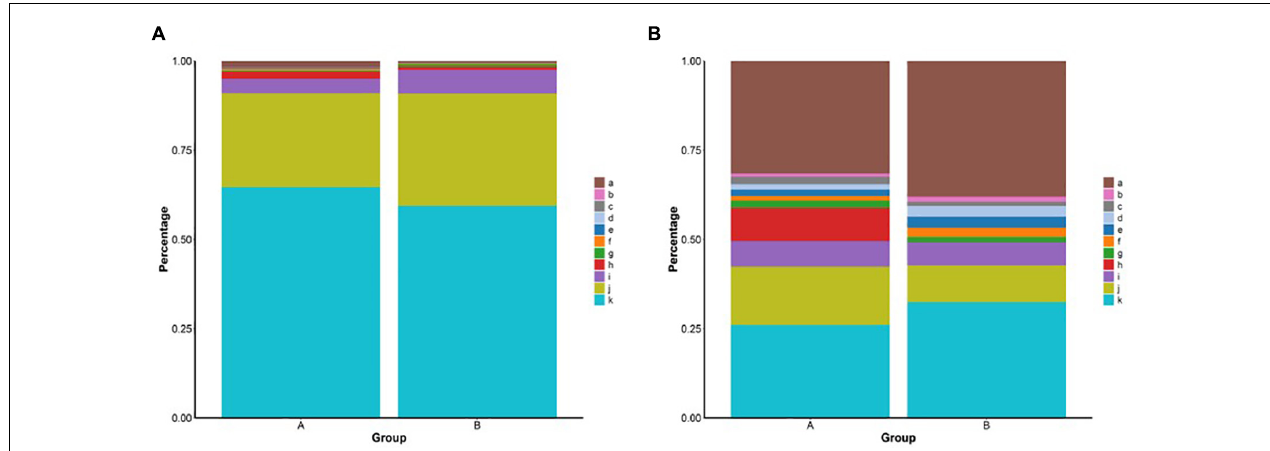
FIGURE 1 | (A) Relative abundance of bacteria phyla from the group A and group B. a: Others, b: Deinococcus-Thermus , c: Patescibacteria , d: Epsilonbacteraeota , e: Spirochaetes , f: Actinobacteria , g: Cyanobacteria , h: Firmicutes , i: Bacteroidetes , j: Tenericutes , and k: Proteobacteria. (B) Relative abundance of bacteria genus from different groups. a: Others, b: Formosa , c: Caulobacter , d: Ruegeria , e: Halocynthiibacter , f: Tamlana , g: Pseudoalteromonas , h: Cobetia, i: uncultured , j: Aquabacterium , and k: Mycoplasma.